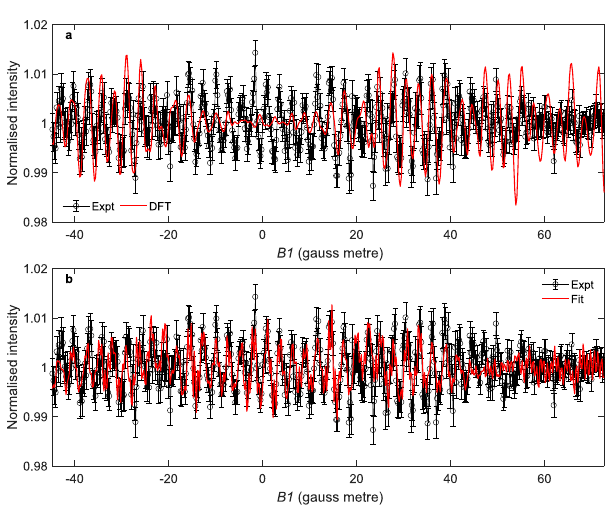
Fig. 4 Comparison of the experimental data with different models. a Comparison of the experimentally measured signal for the J = 2 to J ’ = 0 RID peak (black) and the signal calculated using the S-matrix obtained from DFT calculations (red). The error bars represent standard errors from repeated B1 scans. b Comparison of the experimental data (black) with the simulated signal using the best fi t S-matrix (red). The error bars represent standard errors from repeated B1 scans. Source data are provided as a Source Data fi